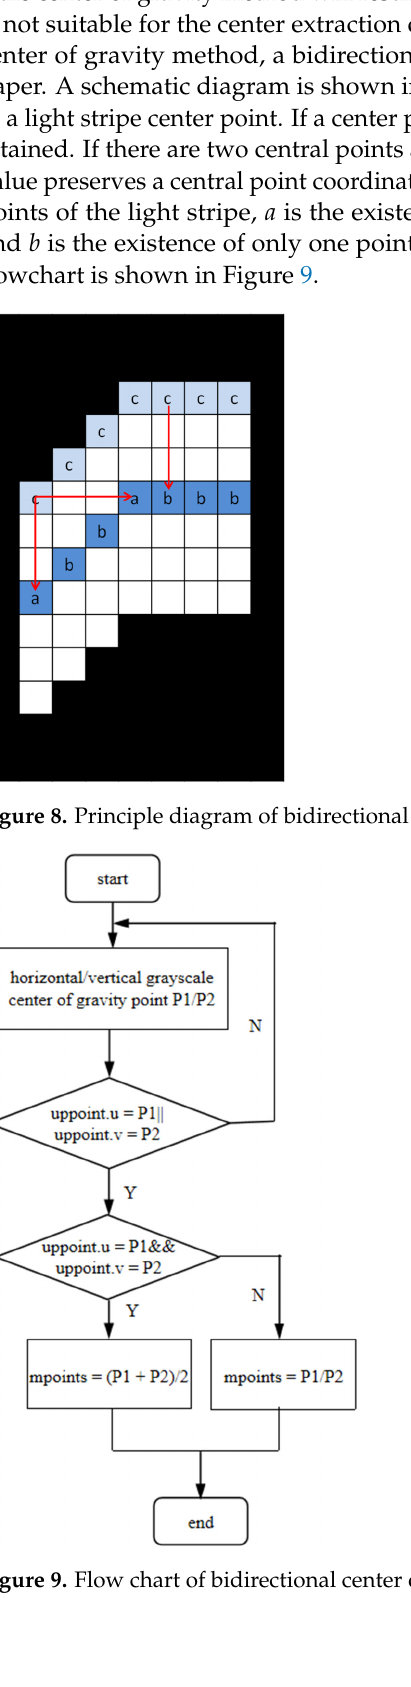
8 of 17 Figure 7. Flow chart of the secondary adaptive image processing area. 2.5. Principle of Bidirectional Center of Gravity Method The barycenter method is to scan by column or row. The centroid of the gray value of the column or row is calculated by the gray-weighted algorithm, and its centroid is taken as the center of the light stripe. The pixel coordinate satisfying the threshold condi- tion is 𝑢 (cid:3036) /𝑣 (cid:3036) . i f is the gray value corresponding to the coordinate point in the image, and the centroid position of the column or row is obtained as 𝑢̄/𝑣̄ . The formula is as fol- lowing: